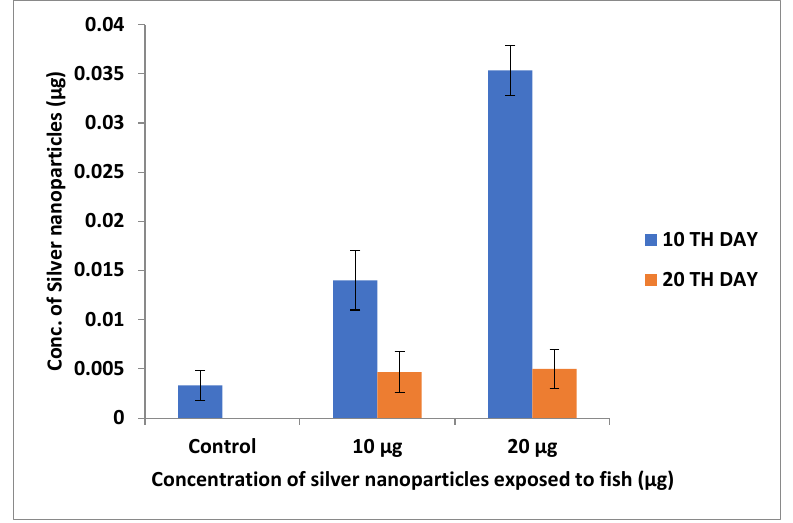
Figure 10. Silver nanoparticle accumulation study using ICP–OES in zebrafishes.